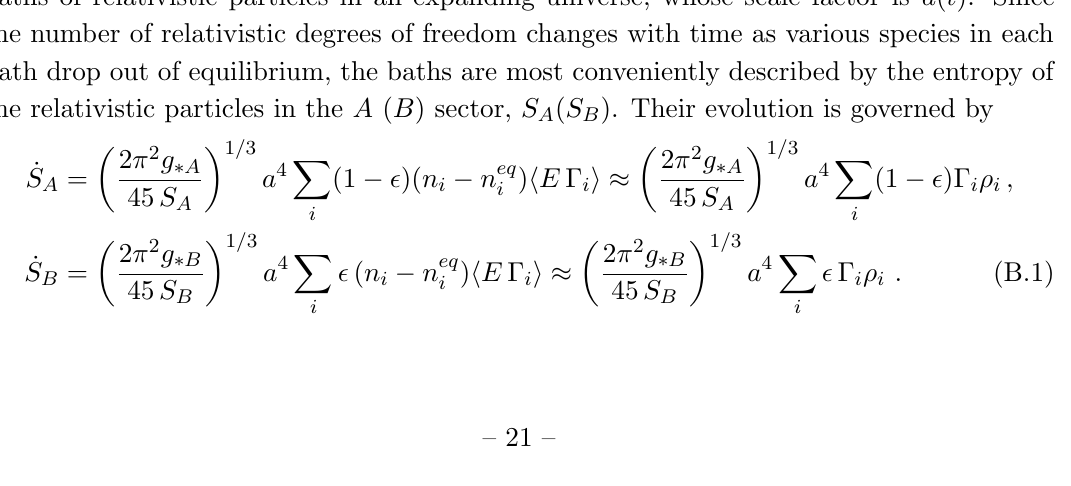
Figure 5 . Left: the partial width of right-handed neutrino N ((cid:2) ) = 1 and all other mixing angles are zero. Right: the e(cid:11)ect of phase space corrections due A i 1 to (cid:12)nite bottom, charm, and tau masses, illustrated via the ratio of partial widths with ((cid:2) and ((cid:2) ) = 1, in each case assuming all other mixing angles are zero. A i 1 g (cid:3) N M N (the case of one sterile neutrino corresponds to g (cid:3) N = 3 : 5). However, in